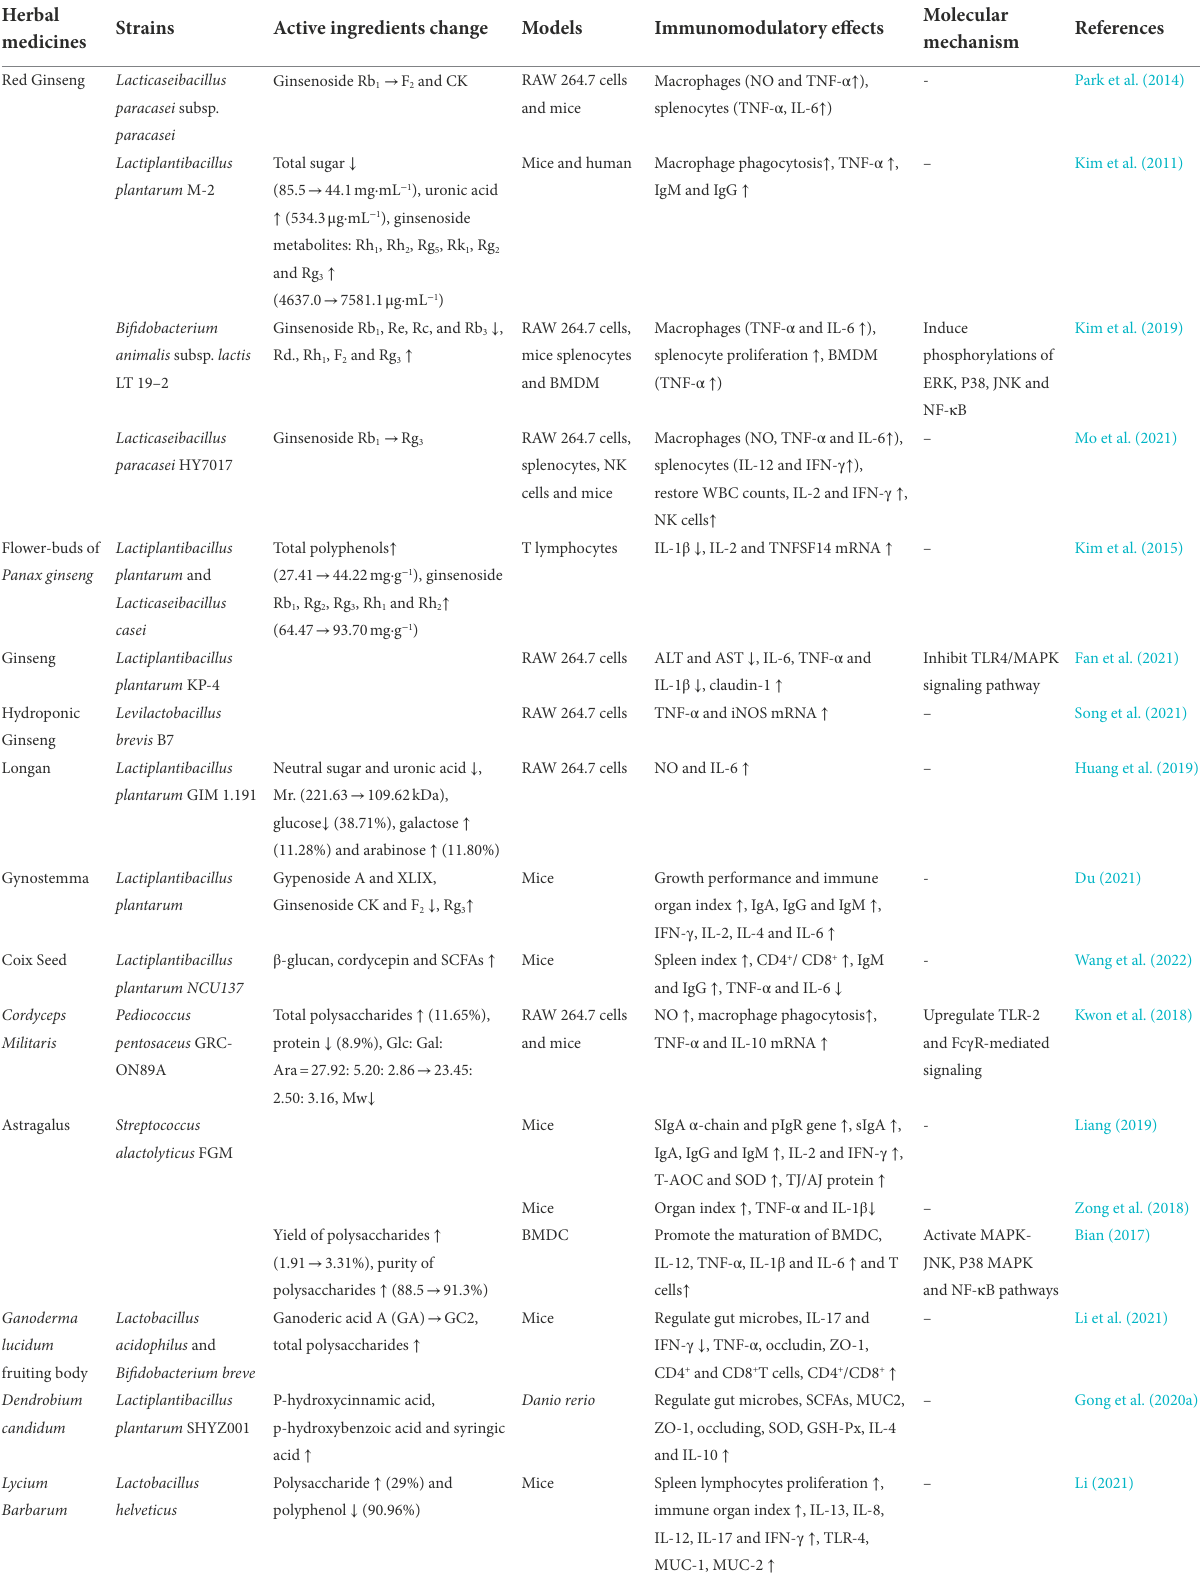
BMDC: bone marrow-derived dendritic cells, WBC: white blood cell, TNFSF: tumor necrosis factor superfamily, ALT: alanine aminotransferase, AST: aspartate aminotransferase, T-AOC: total antioxidant capacity, SOD: superoxide dismutase, ZO-1: zonula occludens-1, MUC: mucoprotein, GSH-Px: glutathione peroxidase, ERK: extracellular regulated protein kinases, JNK: c-Jun N-terminal